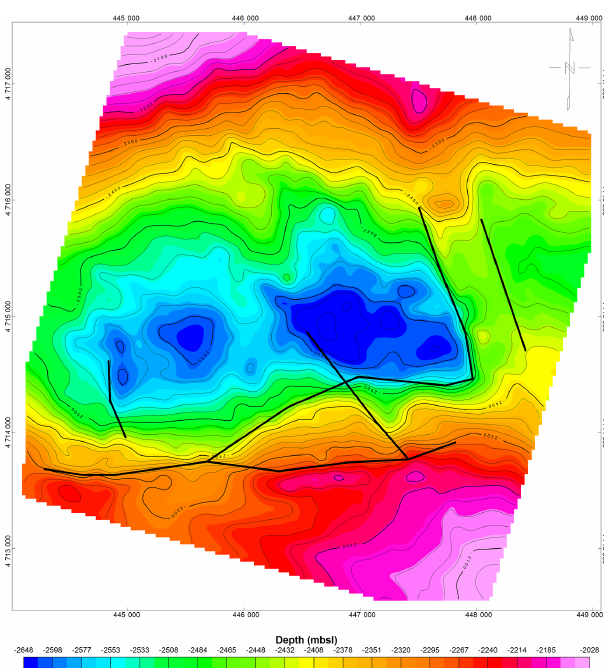
Figure 10. Faults interpreted from the THD of the residual gravity map and shown in Fig. 9, superimposed on the basement topography map. Figure 11. Schematic cross sections in a NW–SE direction, show- ing the different possibilities for explaining the discrepancy to the NW between the gravity model and that presented by Alcalde et al. (2014). (a) Basement high, (b) salt migration, (c) facies change from Keuper evaporites to